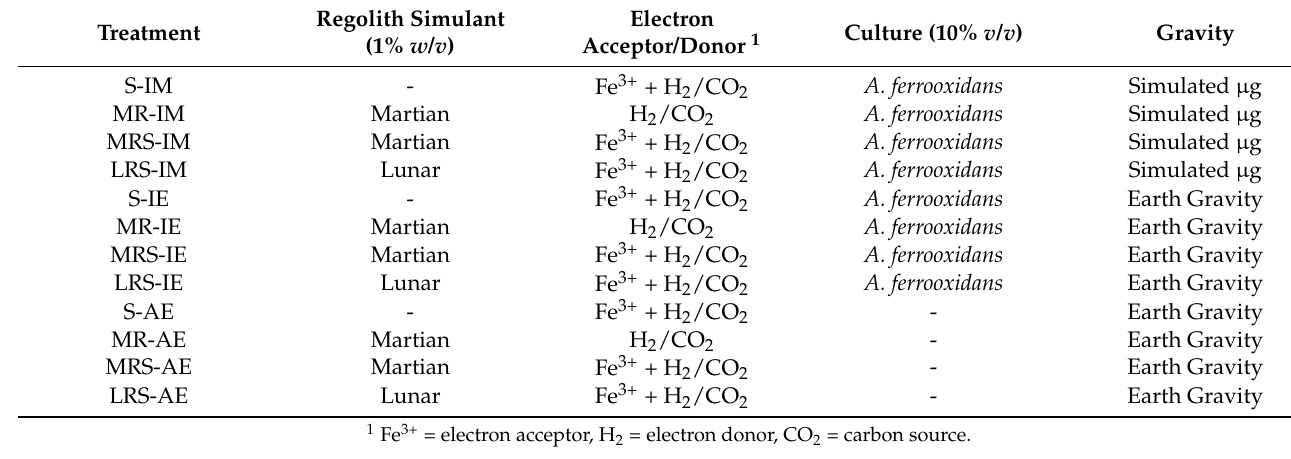
Table 3. Experimental conditions for testing metal solubilization from Martian (MR) and lunar regolith simulants (LR) in the presence and absence of substrates (Fe 3+ ) (S) and A. ferrooxidans inoculum (I) vs. abiotic (A) control under simulated microgravity (M) and/or Earth gravity (E) conditions.